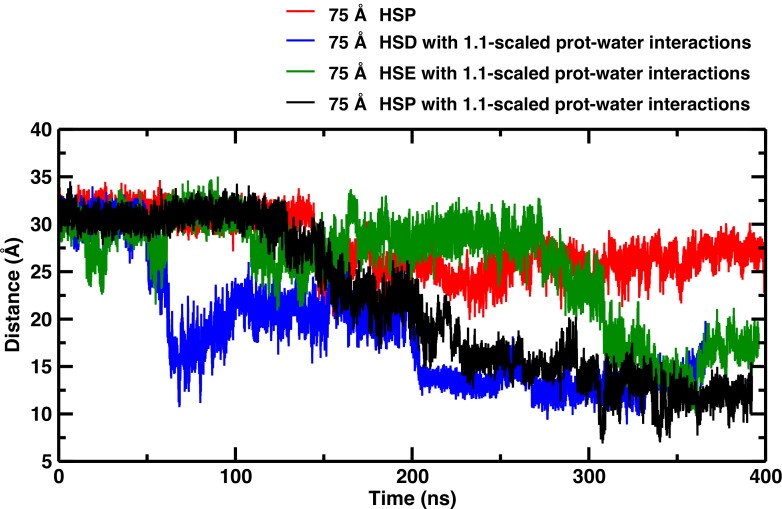
Temporal structural changes of the Cα–Cα distance between His146β1 and His146β2 in the 75 Å box for different simulation conditions.Temporal structural changes of the Cα–Cα distance between His146β1 and His146β2, depending on the protonation state of His 146 in the 75 Å box with and without scaled protein-water interactions.